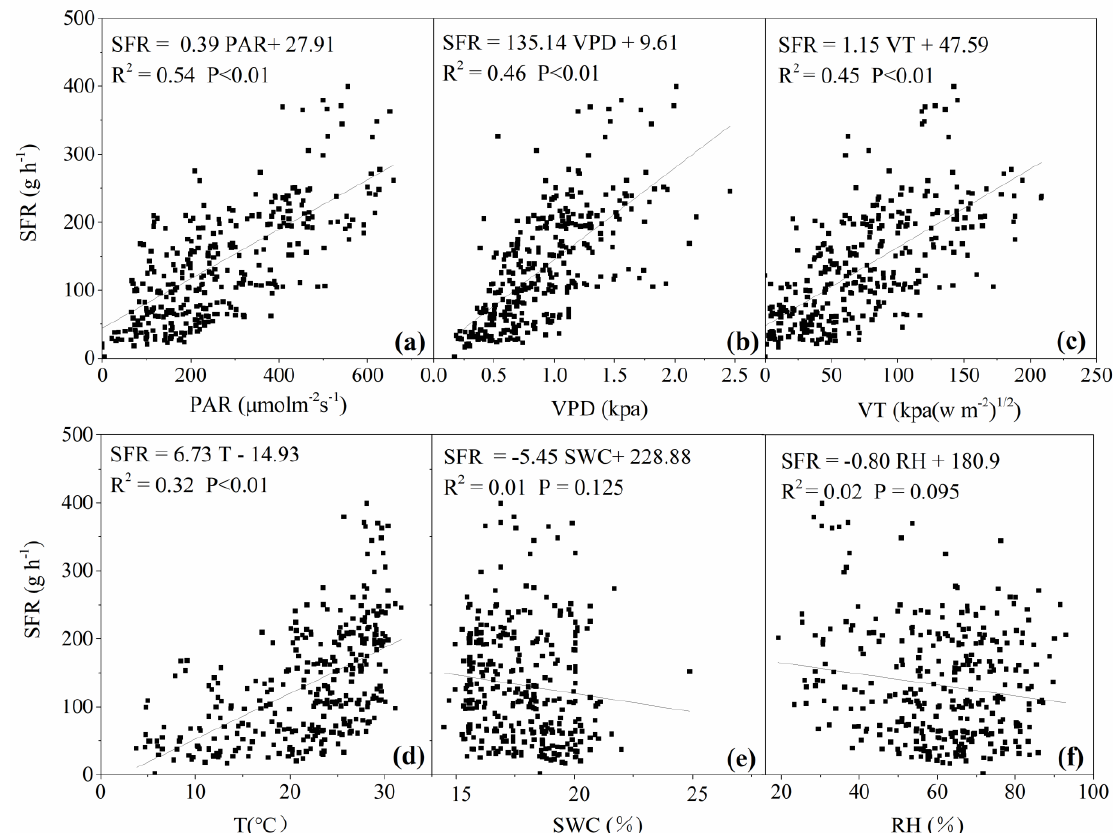
Figure 4. Plots of relationship between daily average sap flow rate (SFR) and six environmental factors—photosynthetically active radiation (PAR, ( a )), vapor pressure deficit (VPD, ( b )), variable transpiration (VT, ( c )), air temperature (T, ( d )), soil water content (SWC, ( e )) and relative humidity (RH, ( f )) in 2017 and 2018 experimental periods.